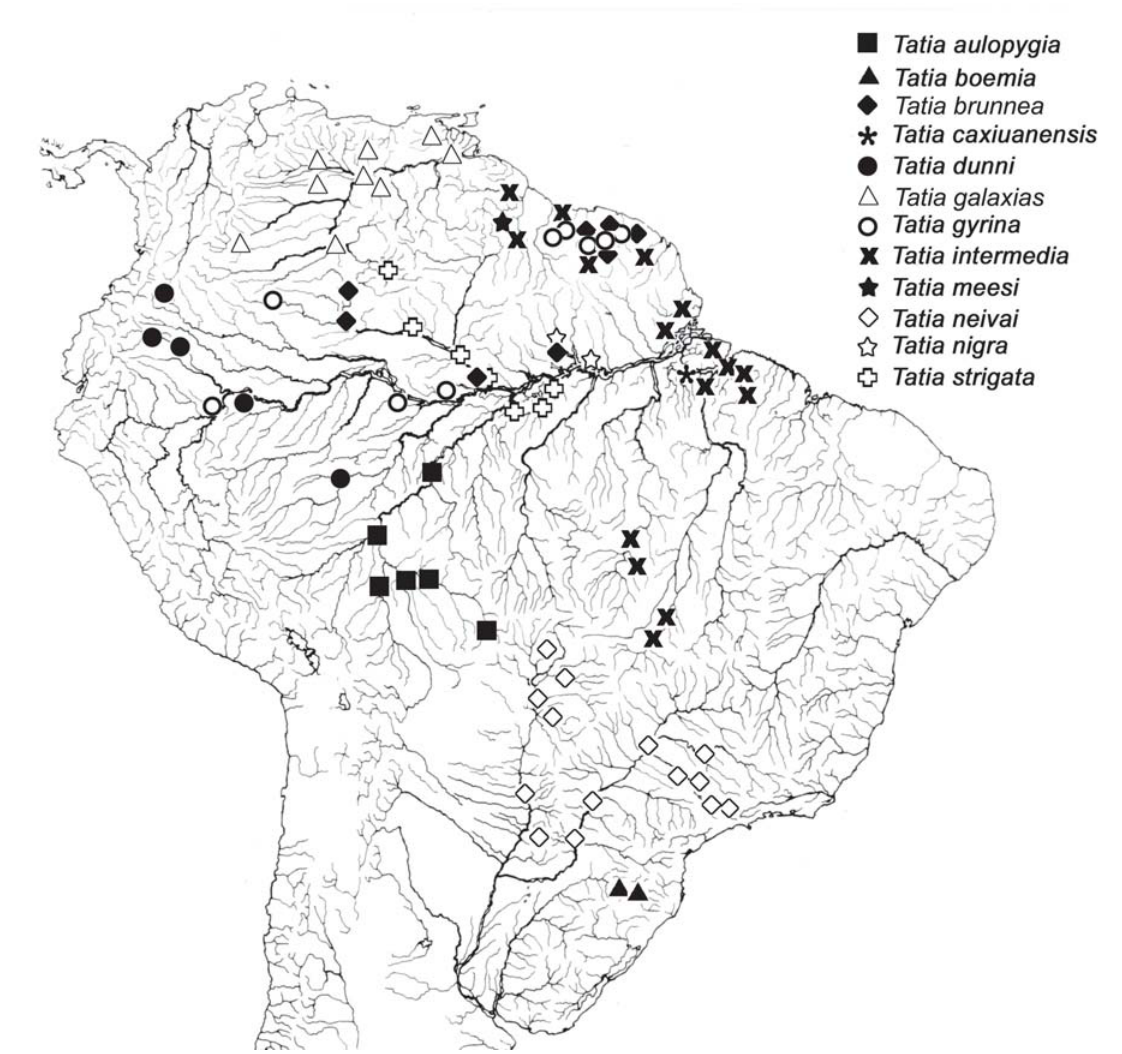
Fig. 6. Drainage map of northern South America illustrating the geographic distribution of the species of Tatia. Symbols may represent more than one locality. Base map by Marilyn